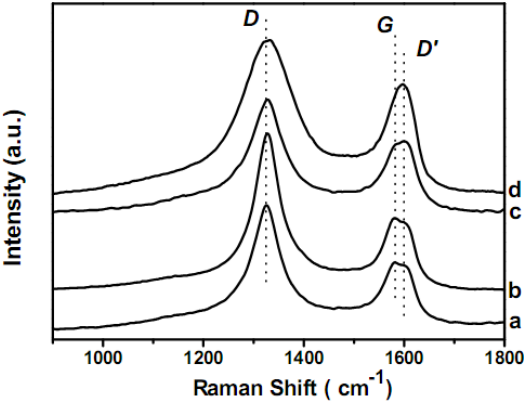
Figure 5. Raman spectra of pMWCNTs (a), oMWCNTs (b), pMWCNT/PdO (c), and oMWCNT/PdO